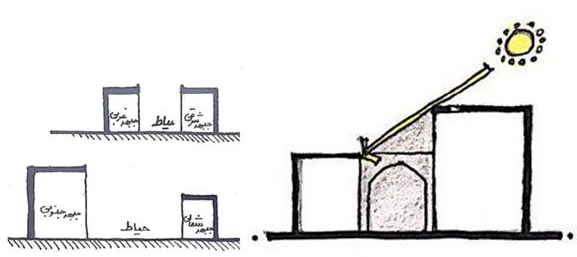
Figure 6. The shade of the south sofeh overlooking the courtyard during the